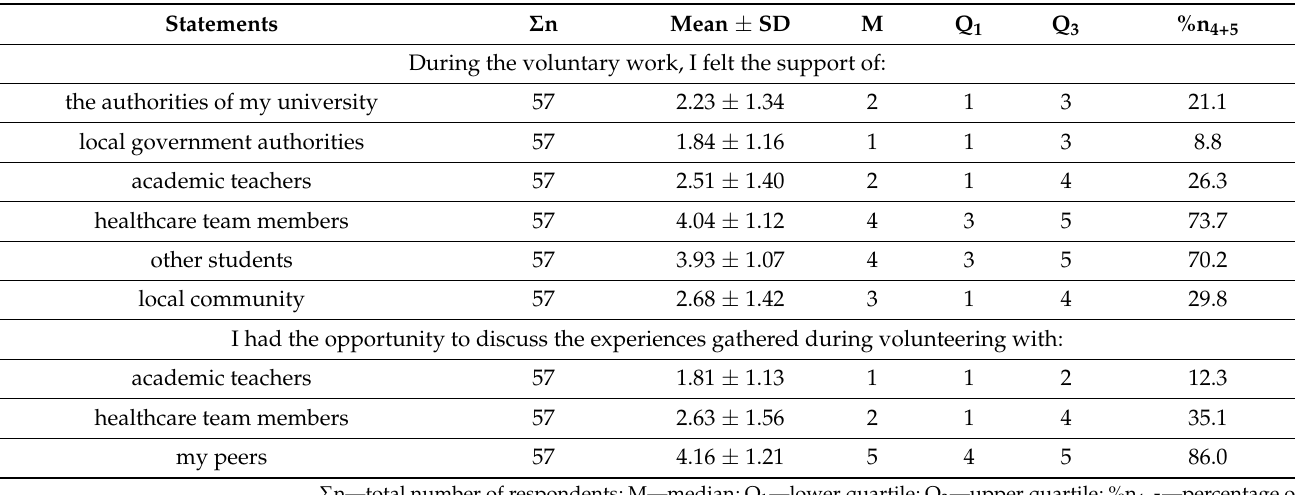
Table 3. Support and reflection opportunities during volunteering.